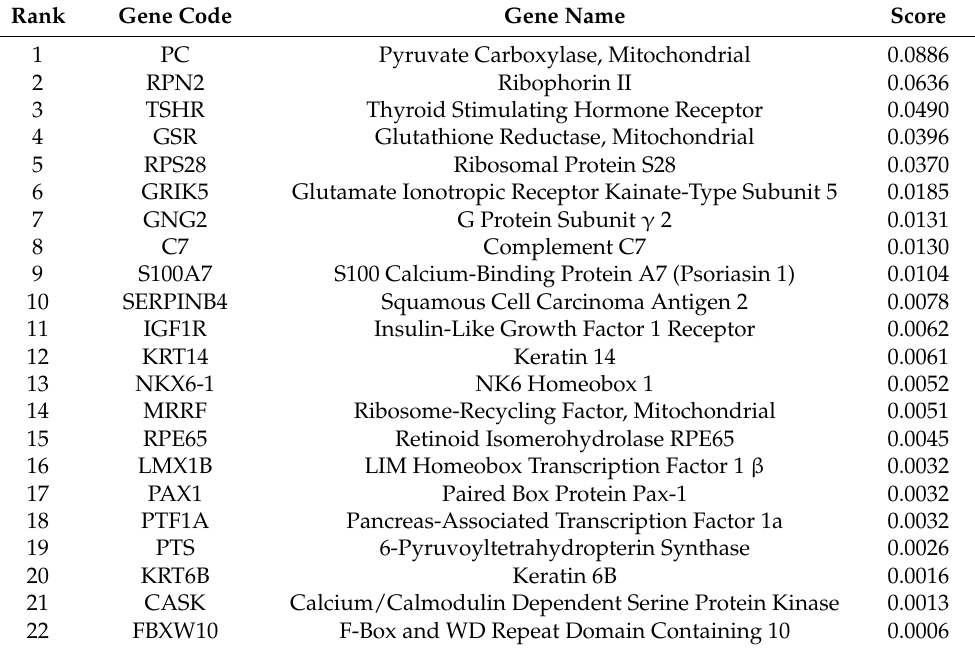
Table 3. Betweenness centrality rank of genes from protein–protein interaction network.